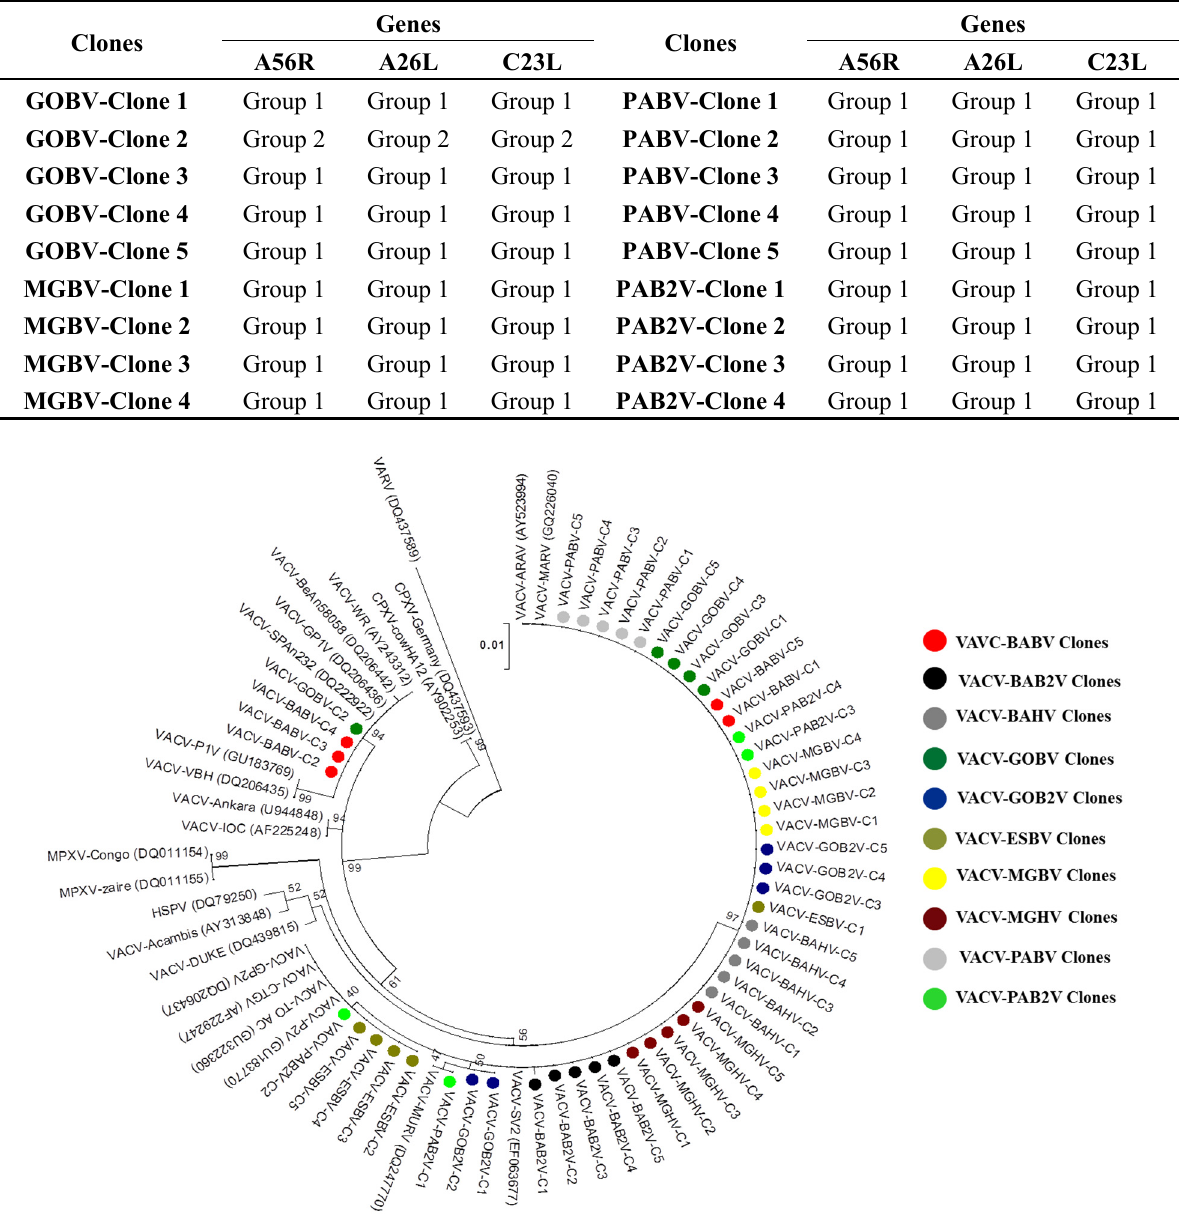
Figure 5. Phylogenetic analysis of viral clones based on the nucleotide sequences of Orthopoxvirus A56R gene. The tree was constructed by the Maximum Likelihood method with 1000 bootstrap replicates based in Tamura-Nei model implemented in